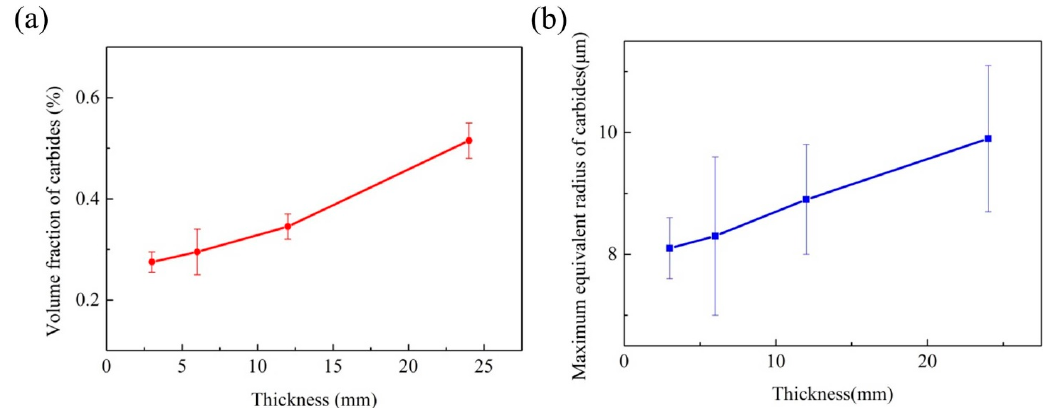
Figure 8. ( a ) The volume fraction and ( b ) the maximum equivalent radius of carbides with different wall thicknesses.